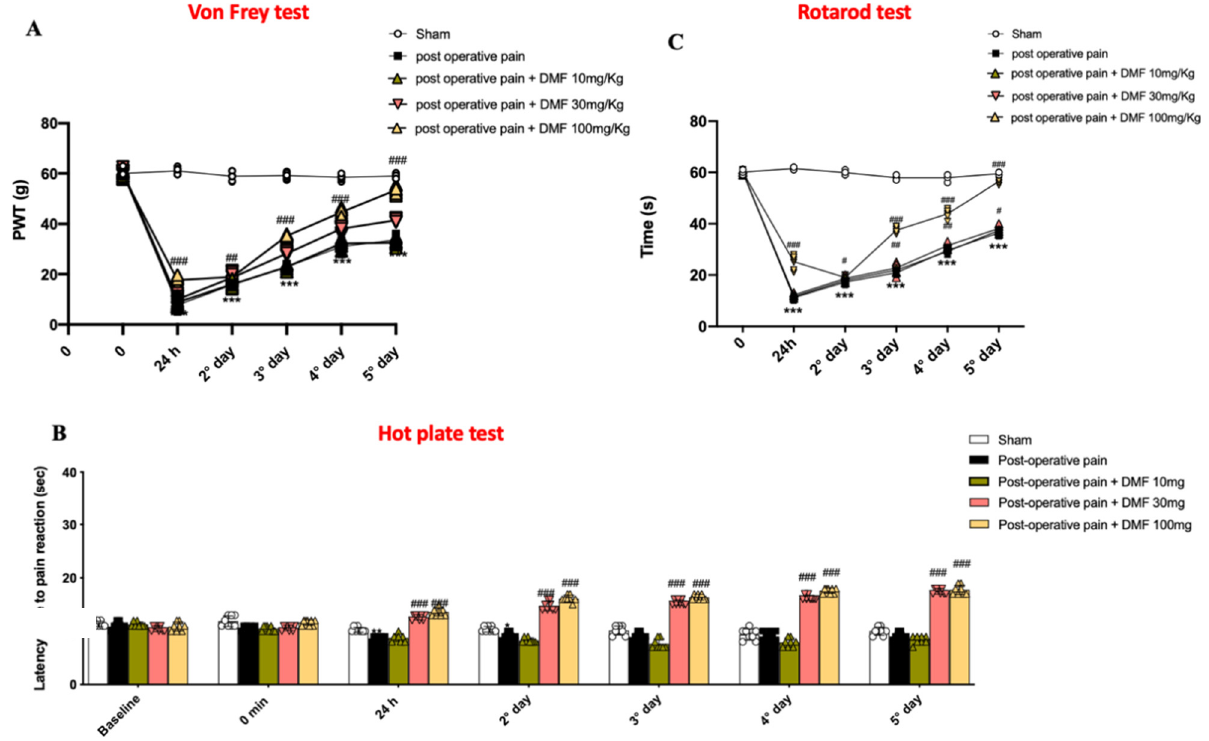
Figure 1. DMF administration reduced mechanical allodynia, thermal hyperalgesiaand motor dysfunction. Von Frey test ( A ), hot plate test ( B ) and rotarod test ( C ) were performed daily from 0 to 5 days. A p -value of less than 0.05 was considered significant; *** p < 0.001 vs. Sham, ### p < 0.001, ## p < 0.01 and # p < 0.05 vs. PO pain.